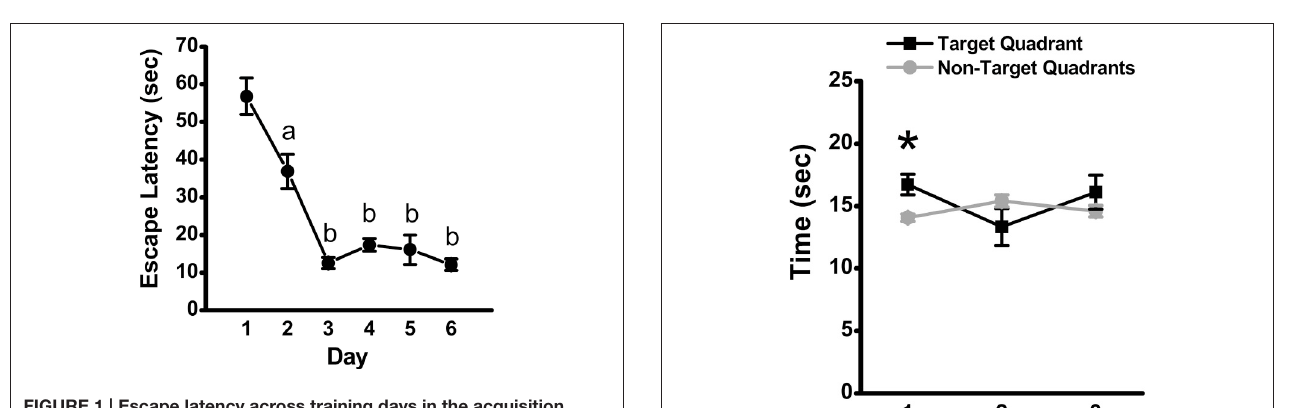
vs. 14.63 ± 0.46 s, respectively; p > 0.05) of the retention phase ( Figure 3